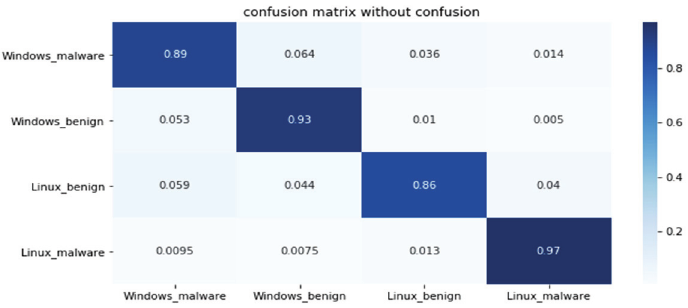
Figure 18. Confusion matrix of Windows and Linux binary.